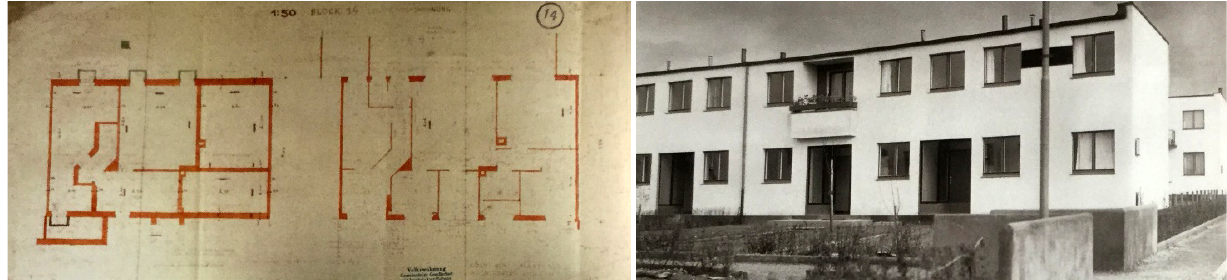
Figure 4. From left to right: W. Riphahn and C. M. Grod, Dammerstock-Siedlung, two-family houses floor plan basement and ground floor, Karlsruhe, 1928; West view photograph. Source: Atelier Bauer